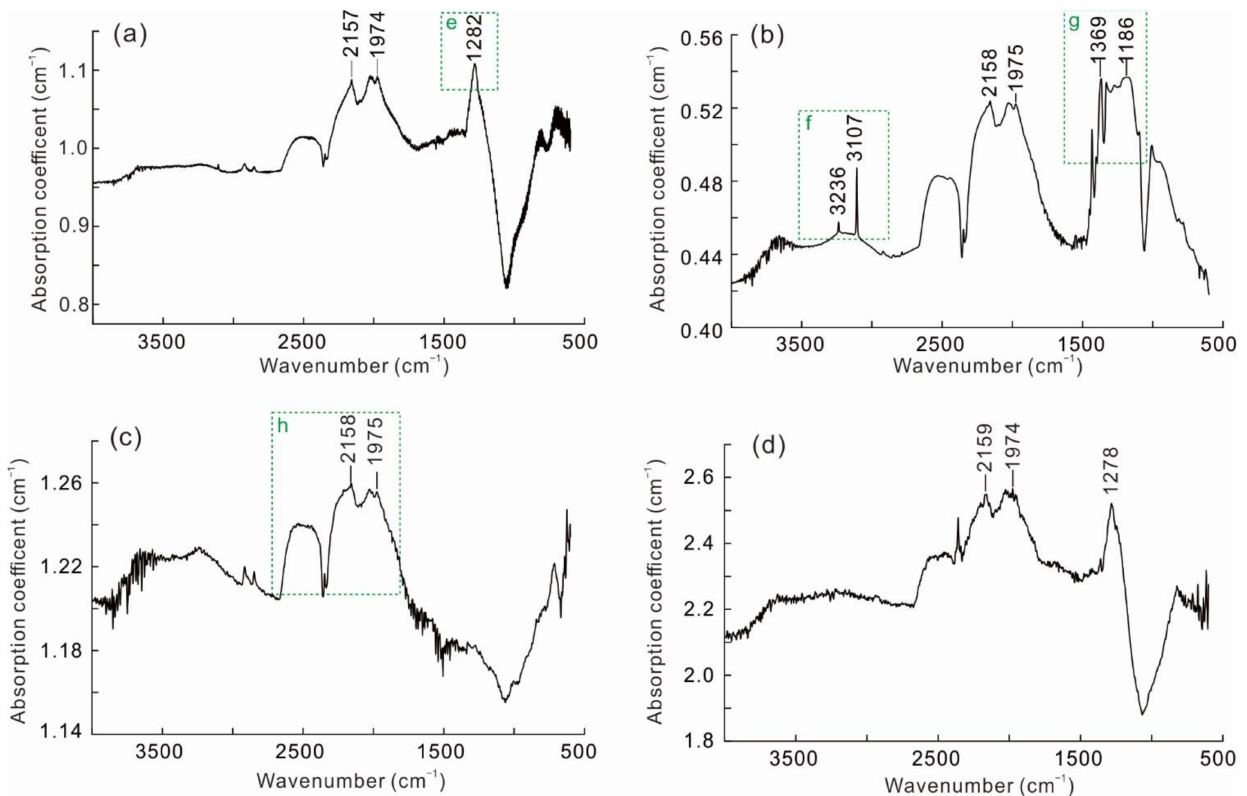
Figure 3. The FTIR strata of representative diamonds in three belts. ( a ): SL-2 (IaA), ( b ): HQ23-2 (IaAB), ( c ): Q29-1 (IIa), ( d ): PO-1 (IaA). e: C center; f: absorption features of H atoms, g: two-phonon region with intrinsic diamond absorption features; h: the typical feature of type IaAB